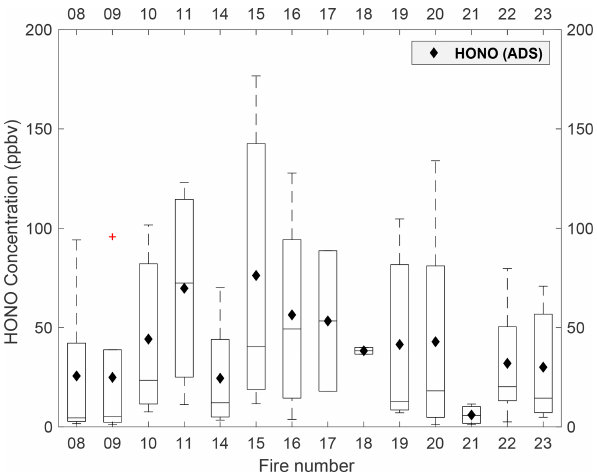
Figure 2. Box plot of MC–IC HONO measurement with 5min res- olution over the course of each fire. Each box whisker represents the 5th, 25th, 50th, 75th, and 95th percentile of the HONO concentra- tion during each collection period. The black diamond is the mean HONO concentration recovered from ADS collection. The red cross symbolizes outliers. Note that no isotopic analysis was performed for fire no. 12 (shown in Fig. 1) due to an insufficient amount of collected